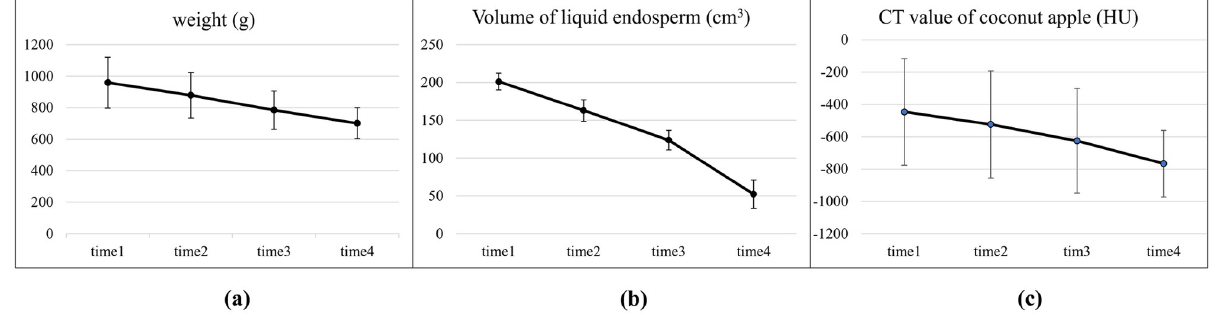
Fig 8. Coconuts changes observed over three